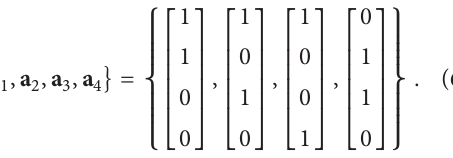
Algorithm 1. In Step 3 of the improved QRD-M algorithm